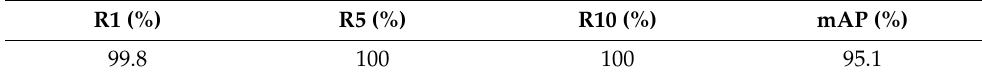
Table 5. Accuracy of re-identification module on our